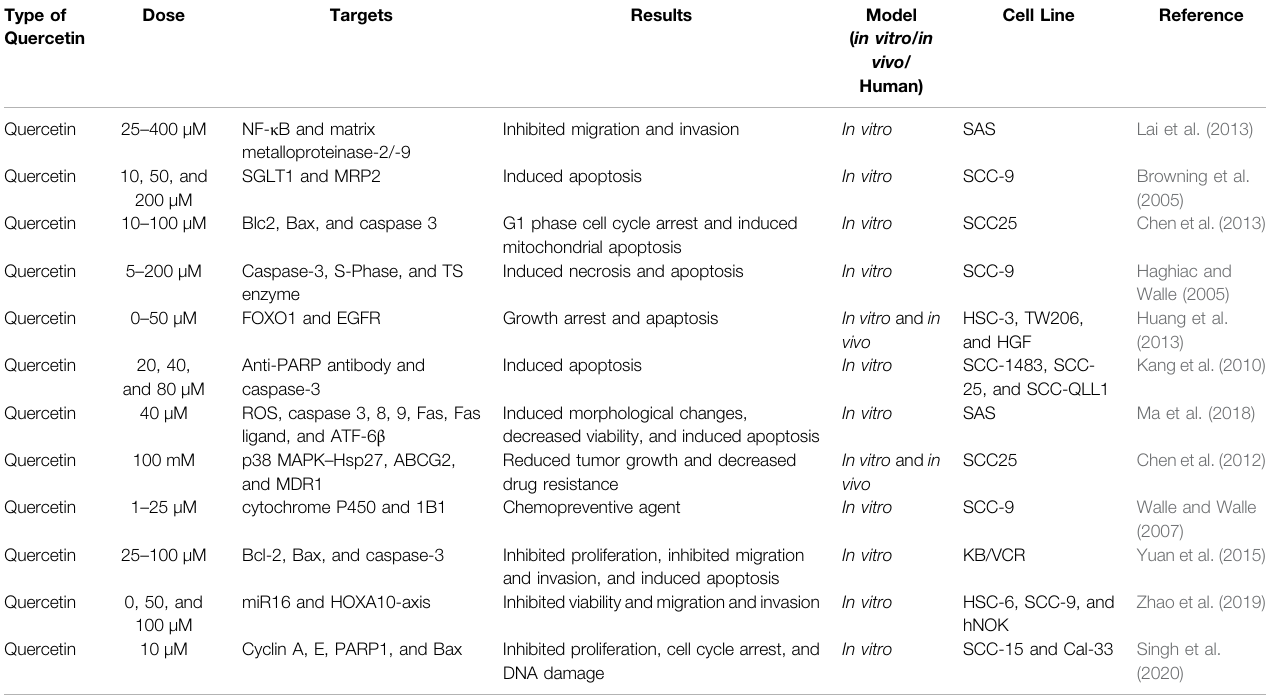
TABLE 6 | Studies on the therapeutic effects of quercetin in oral